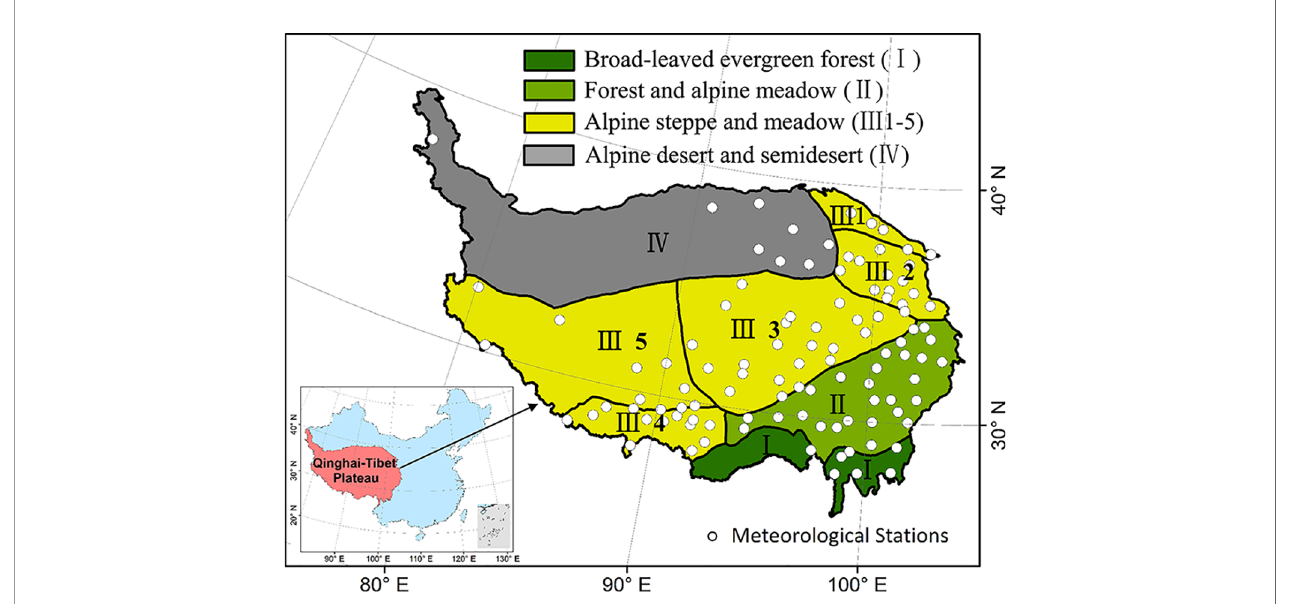
FIGURE 1 | The spatial distribution of meteorological stations and ecological regionalization on the Qinghai – Tibet Plateau (QTP). (Inset) The location of the study region within China. The study area including four ecoregion types: broad-leaved evergreen forests ecoregion (I), forest and alpine meadow ecoregion (II), alpine steppe and meadow ecoregion (III), and alpine desert and semidesert region (IV). The ecoregion III was divided into fi ve subtypes: needle-leaved forest and alpine meadow ecoregion (III 1), agriculture and pasturage ecoregion in eastern Qinghai (III 2), alpine meadow ecoregion (III 3), agriculture and pasturage ecoregion on the southern QTP (III 4), alpine steppe ecoregion (III